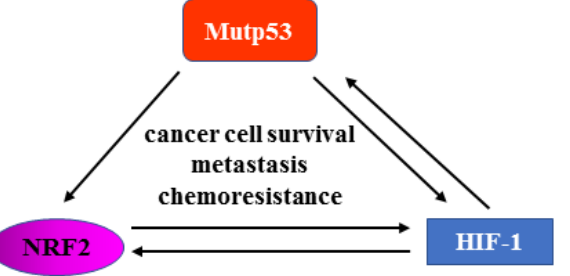
Figure 5. Reciprocal control between mutp53, NRF2, and HIF-1. Mutp53 can sustain NRF2 and HIF-1 activity. NRF2 and HIF-1 can control each other, as well as HIF-1 and mut-p53. The interplay among the oncogenic pathways contributes to tumor progression, metastasis, and chemoresistance.